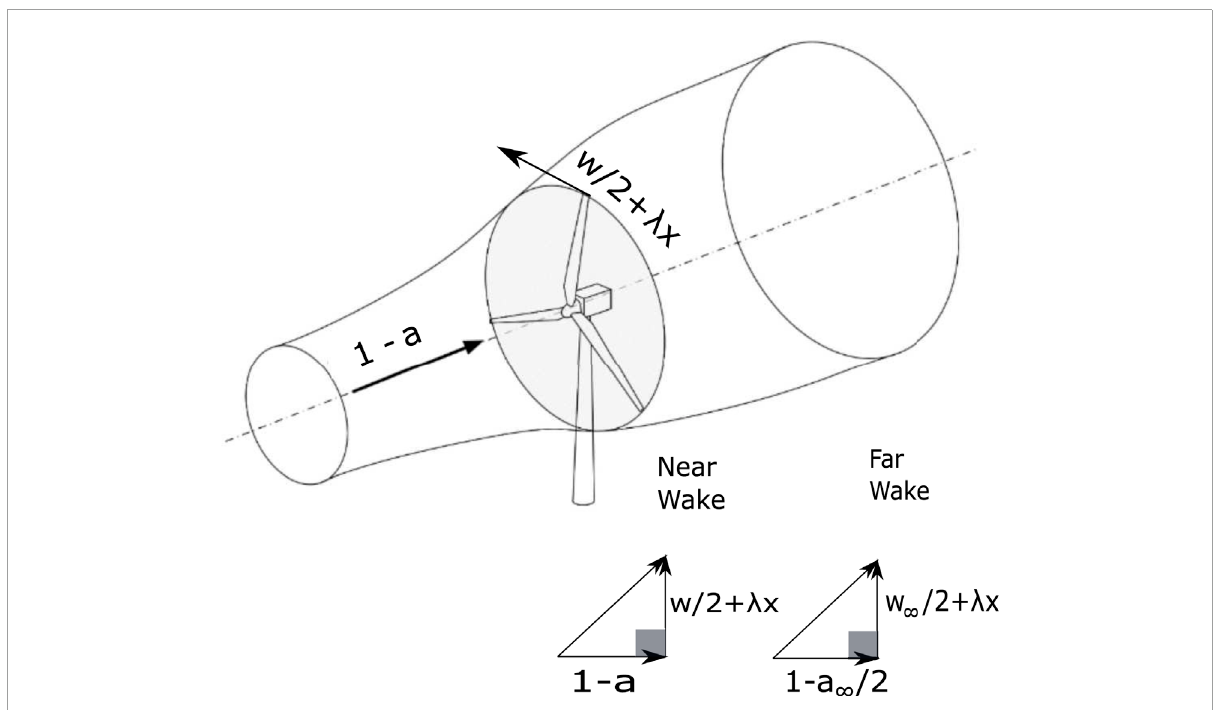
FIGURE 1 Perspective view of the actuator disc representation of a wind turbine rotor and the streamtube containing the flow that passes through the rotor. The arrows indicates the directions of the velocities which are normalized by the freestream velocity. The shaded circle shows the actuator disc. The velocity triangles are not to scale. Equation 14 gives p = ( 1 − a )/( λ + w /( 2 x )) and Equation 11 gives p ∞ = ( 1 − a ∞ / 2 )/( λ + w ∞ /( 2 x )) . The upper figure is adapted from